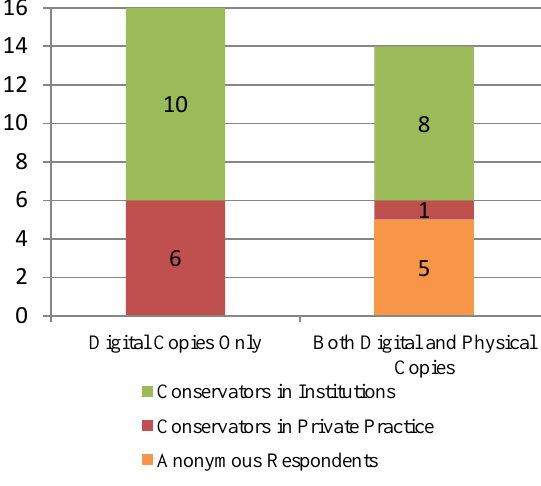
Figure 1. Breakdown of Storage Methods